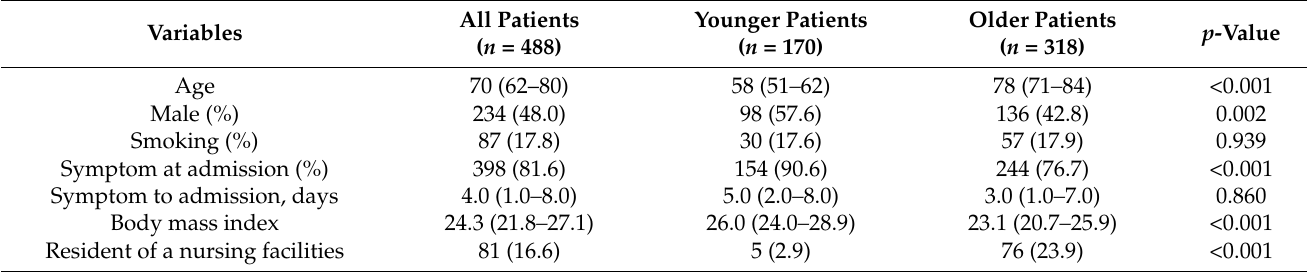
Table 1. Baseline characteristics of patients with severe